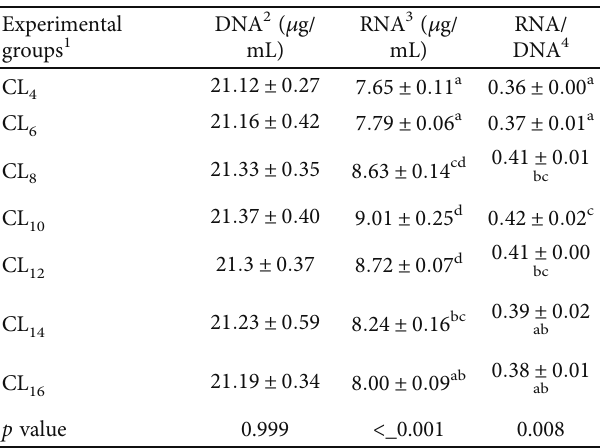
Table 5: DNA and RNA contents and RNA-DNA ratio in the muscle of GIFT juveniles cultured in IGSW of 15 ppt and fed with experimental diets for 60